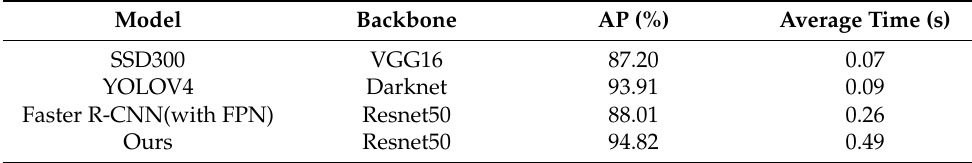
Table 4. Performance of different model on Dataset